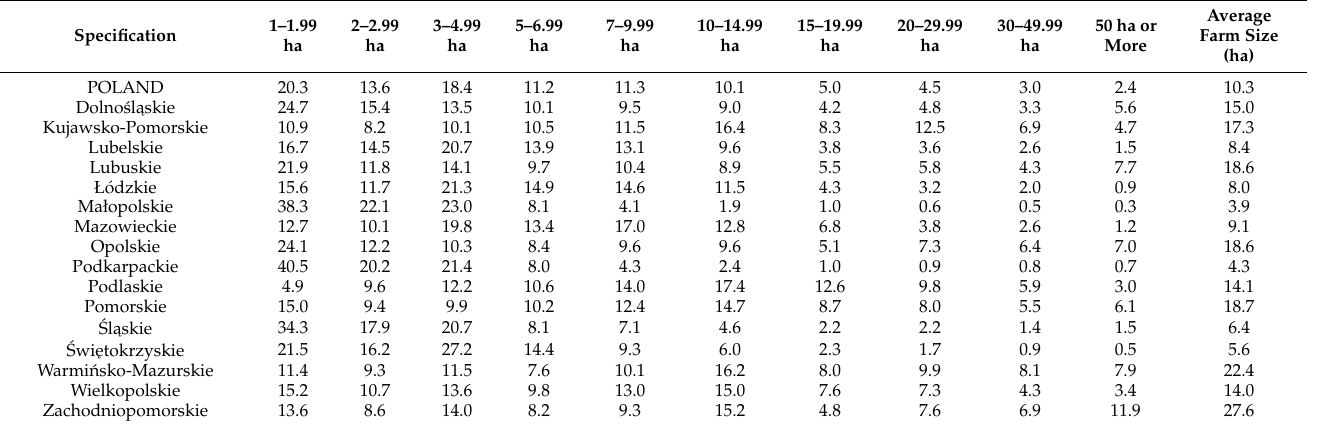
Table 2. Structure of farms in each voivodeship and in Poland, grouped by utilized agricultural area in 2018 (%).